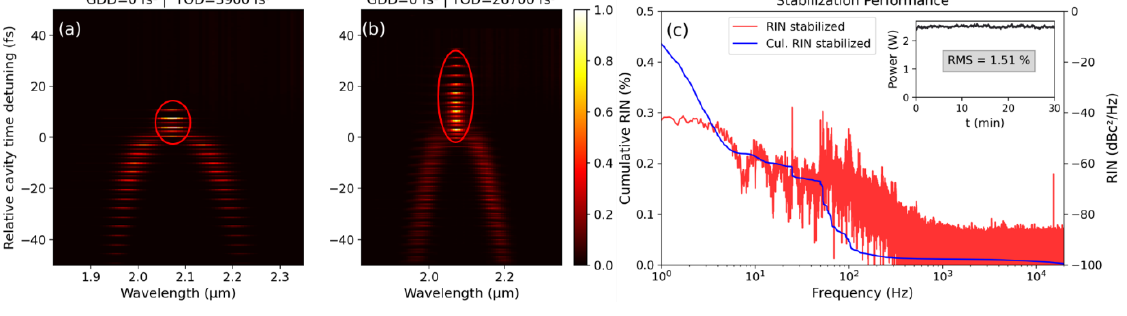
Fig. 1. Extending the self-locking region by changing the third-order dispersion (TOD). (a), (b) Experimental cavity length scans for small and large values of TOD, respectively. The self-locking region is marked with the red ellipse. (c) Relative intensity noise (RIN) of the signal output of the DROPO for active PI controller (red). The cumulative RIN for the stabilized system is less than 0.9% (blue). Inset shows longtime measurement of the output